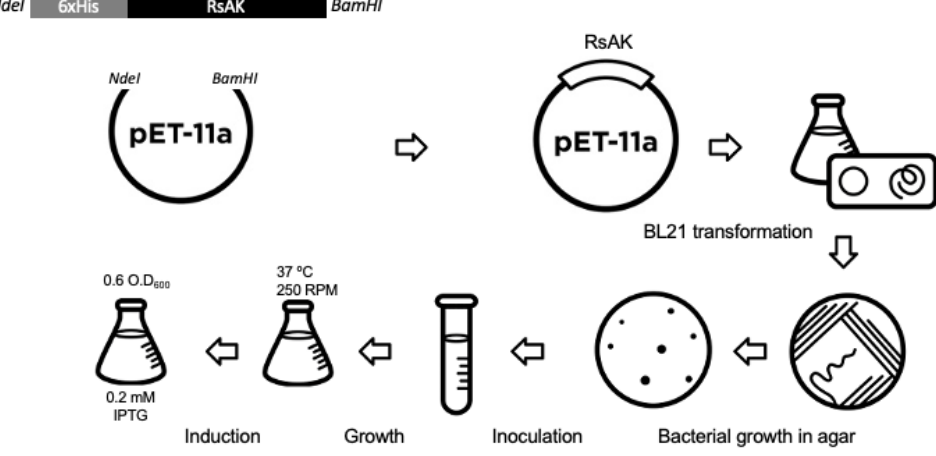
Figure 6. Scheme of the cloning and expression methods to produce Rs AK. The recombinant protein was purified by metal ion affinity chromatography (IMAC)